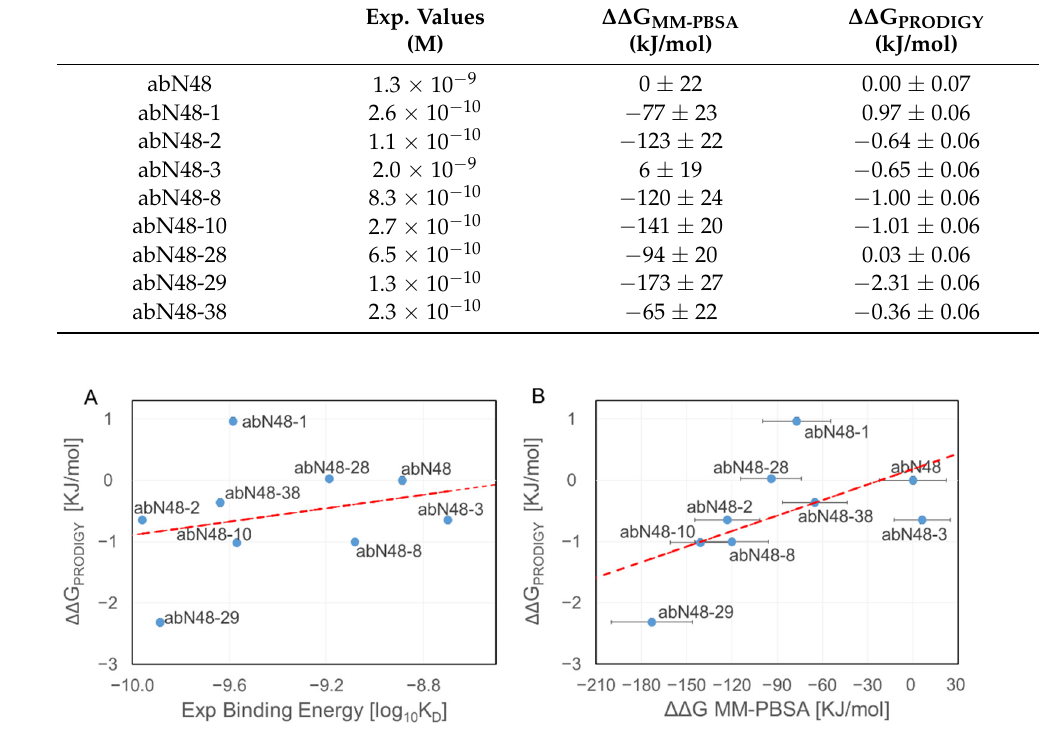
Figure 3. Details of molecular dynamics simulation of abN48 and abN48-2. ( A ) Illustration of abN48 and abN48-2 FABs and their interaction with pepN9-19 (colored in pink; Phe14 and Trp15 are shown in gray and purple, respectively). The two antibodies shared the same light chain (in red) while the heavy chains differed only for two residues (two serines of CDR3 of abN48 were mutated in ar- ginines in abN48-2). ( B ) Histogram of the binding energy computed using MM-PBSA on the abN48- pCXCR2 complex (black) and abN48-2-pCXCR2 complex (red). The two distributions had clear sep- arate picks and the t-test showed a p -value << 0.05. Root-mean-square fluctuation (RMSF) of abN48 and abN48-2 heavy chains ( C ) and light chains D ). The maturated antibody showed higher fluctu- ations than the original one, in agreement with the β factor of the crystal structure.